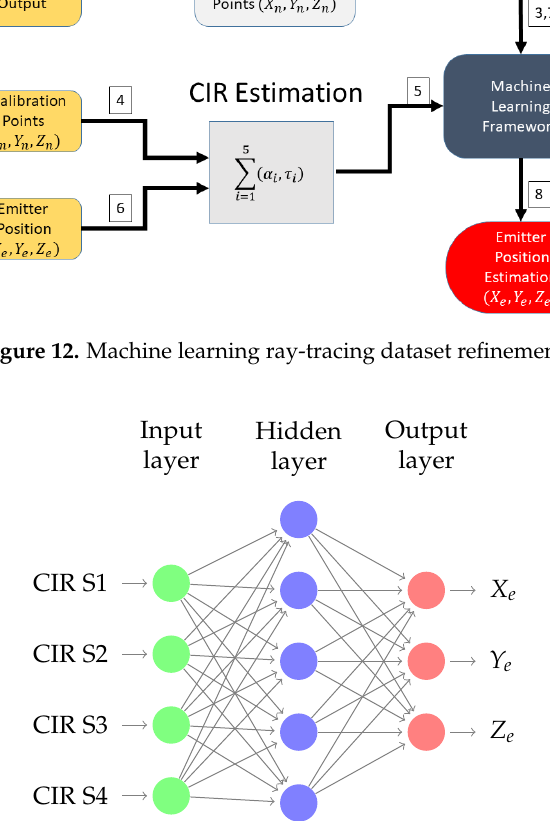
Figure 13. Neural network for position